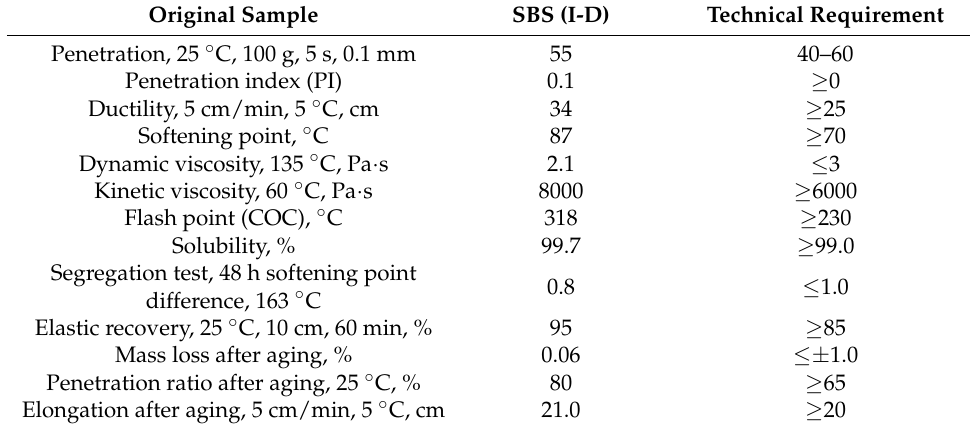
Table 3. Material properties of SBS1.